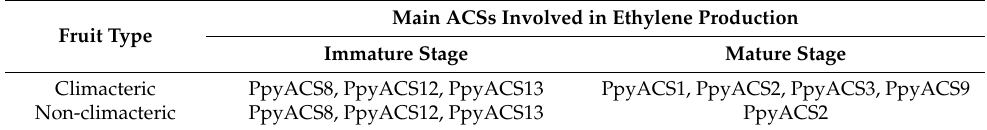
Table 2. Summary of PpyACSs gene expression during sand pear fruit development and ripening. Main ACSs Involved in Ethylene Fruit Type